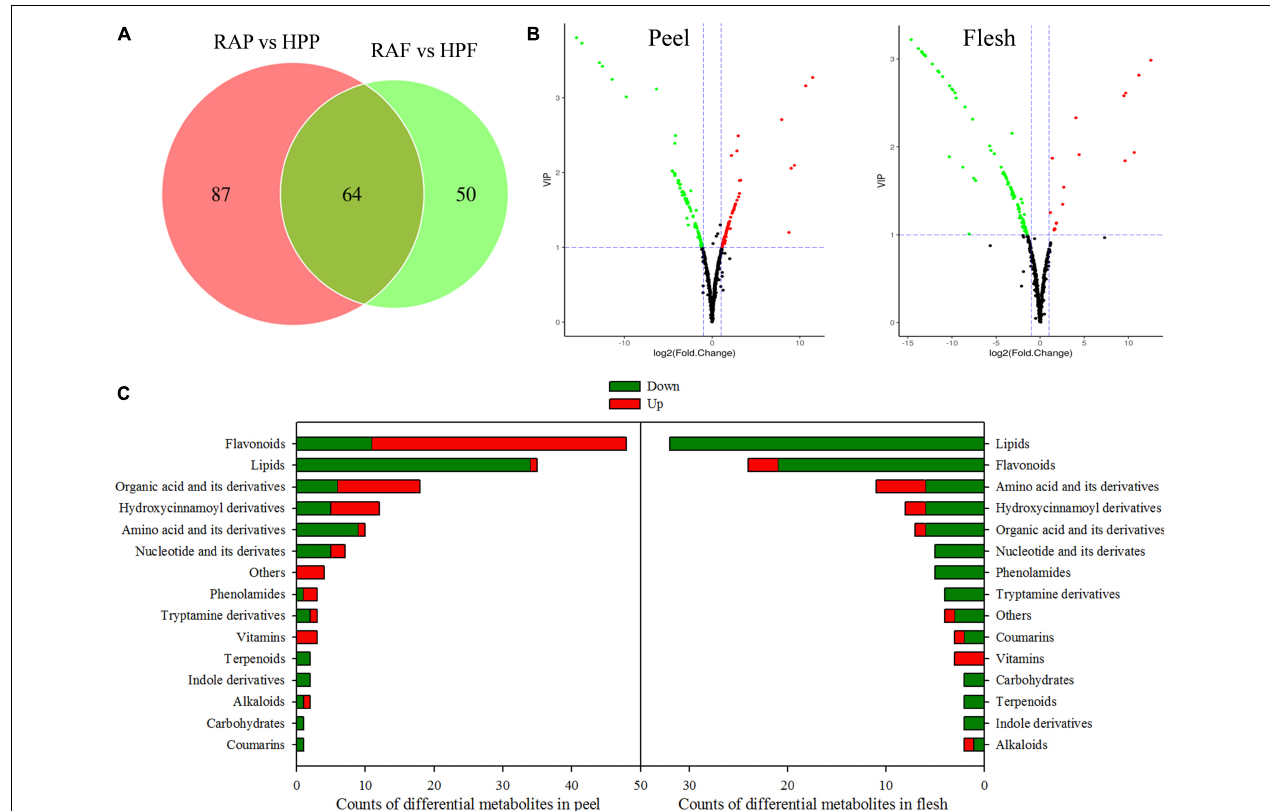
FIGURE 3 | Analysis of the differential metabolites in the peel and flesh of HP compared with RA. (A) Venn diagram of the differential metabolites. (B) Volcano plot of differential metabolites in the peel and flesh samples, respectively. Red scatter point indicates upregulated metabolite, whereas green scatter point indicates downregulated metabolite. (C) Functional categories and number of the differential